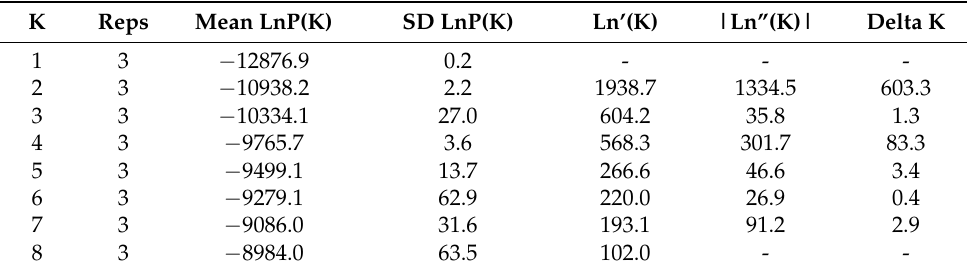
Table 5. Simulation statistics for determining the optimal structure of the tropical japonica population.